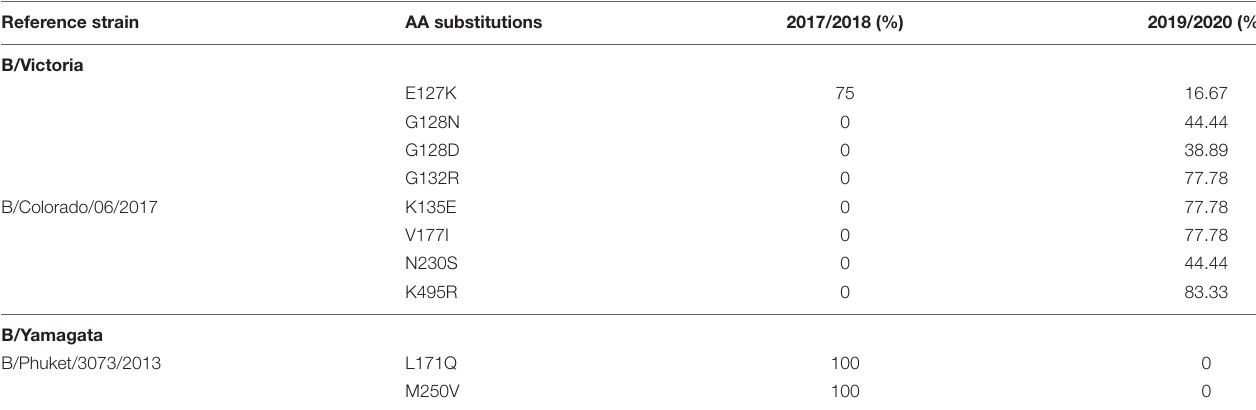
TABLE 6 | Amino acid substitutions identified in HAs of influenza B/Victoria and B/Yamagata during the 2017/2018 and 2019/2020 season. Reference